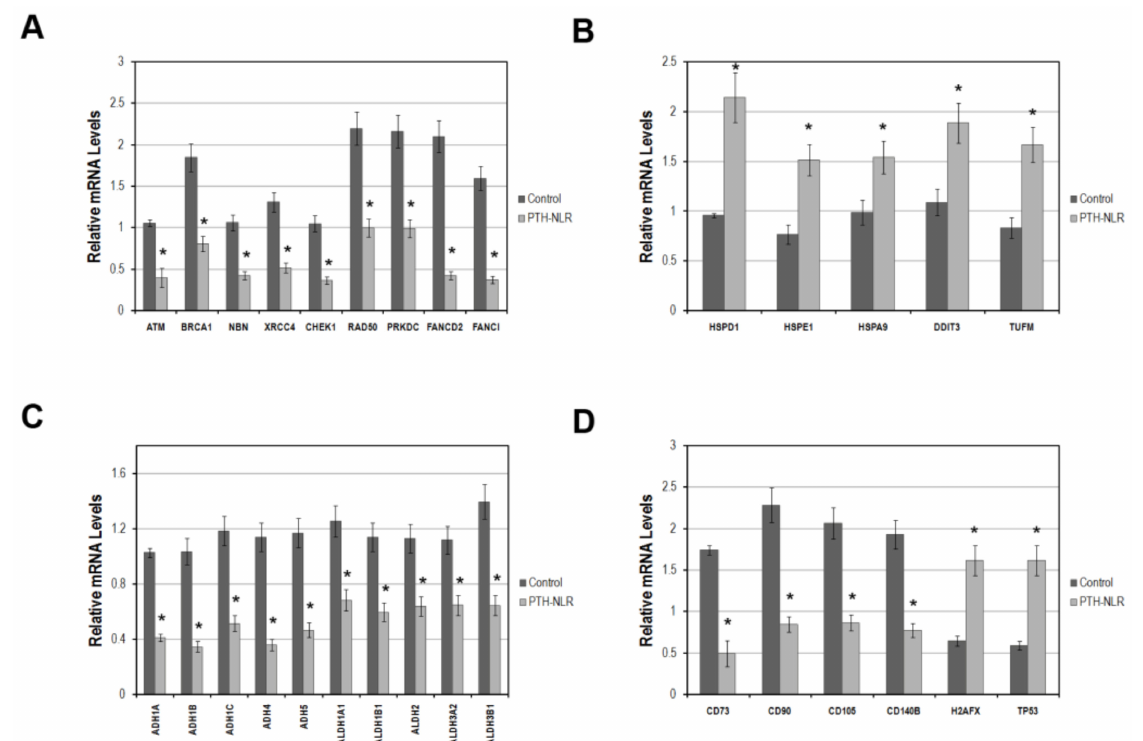
Figure 4. The mRNA levels of genes related to DNA damage response, mitochondrial stress response, metabolic detoxifica- tion, lineage markers on liver-derived stromal cells, and DDR activation markers in LDLT recipients with HCC. ( A ) DNA damage response genes were significantly reduced in recipients’ liver tissues with PTH-NLR. ( B ) This drastic increase of the mitochondrial stress genes was also observed in liver tissues of PTH-NLR recipients compared to those in control subjects. ( C ) The detoxifying genes of alcohol and aldehyde dehydrogenase families were significantly reduced in recipients’ liver tissues of PTH-NLR group compared to those in control. ( D ) The mean levels of four major lineage markers on liver stem cells were significantly decreased, whereas the DDR activation markers TP53 and H2AFX increased in the patients’ liver tissues of PTH-NLR group compared with those control recipients. Data represents 15 independent cases in each group using GAPDH as a reference gene for internal control. Significance is established at a p -value of 0.05 (*) by the Mann–Whitney u